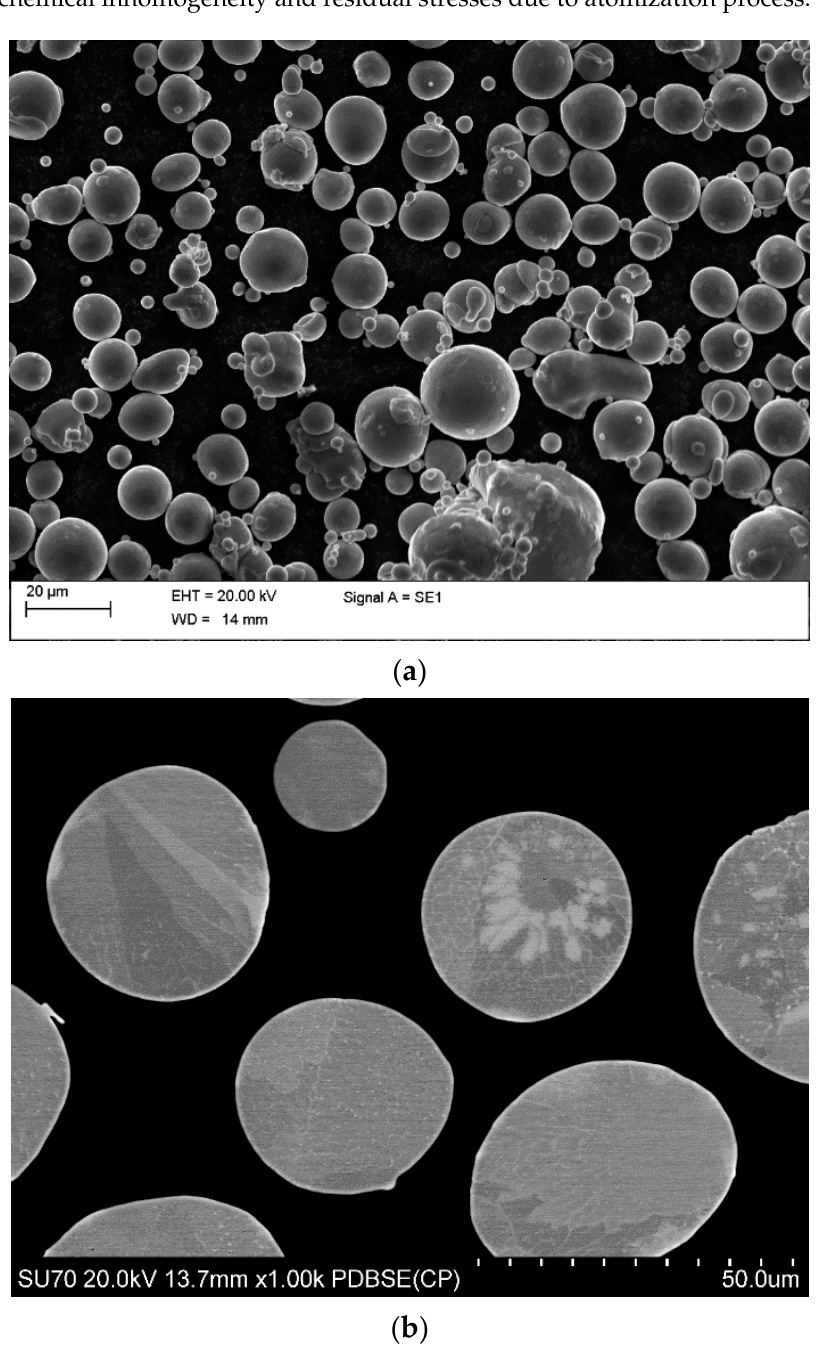
Figure 1. SEM image of the NiTi powder used for the LPBF process ( a ) overview of the powder shape (secondary electron micrograph), ( b ) powder section (Backscatter electron micrograph).